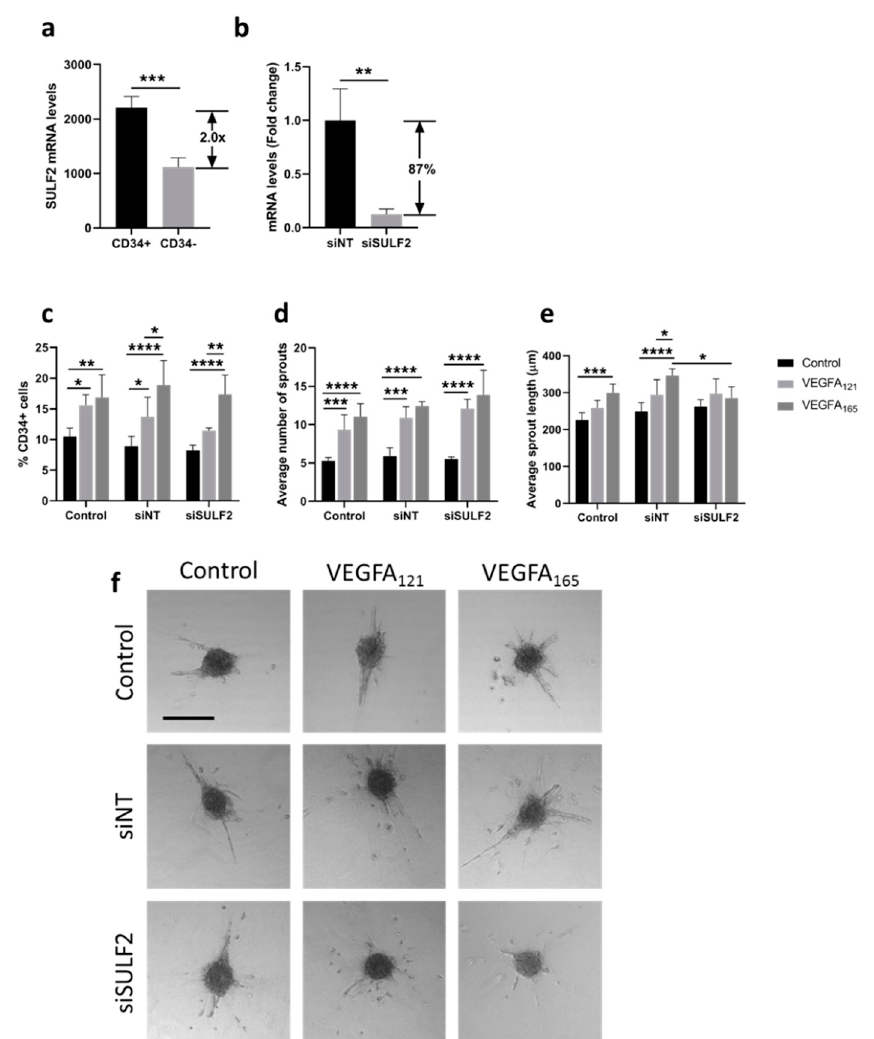
Figure 1. Effect of SULF2 knockdown on VEGFA121- and VEGFA165-induced tip cell formation and sprouting. ( a ) Microarray analysis showed enrichment of SULF2 mRNA in CD34 + cells as compared to CD34 - cells. HUVECs were treated with siNT, si SULF2 or left untreated (Control) and were subsequently cultured in the presence or absence of VEGFA 165 or VEGF 121 . ( b ) Treatment of cells with siSULF2 resulted in a significant reduction in mRNA levels of 87% as compared to treatment with siNT. ( c ) Flow cytometric analysis of CD34 + cells (% of total number of cells). Average number ( d ) and length in µm ( e ) of sprouts per HUVEC spheroid. ( f ) Representative images of sprout formation from HUVEC spheroids. Results are presented as the mean ± standard deviation of three HUVEC donors. Unpaired T-tests ( a , b ), two-way ANOVA ( c ) or two-way mixed ANOVA ( d , e ) were used to calculate statistical differences (* p < 0.05, ** p < 0.01, *** p < 0.001, **** p < 0.0001). Scale bar = 250 µm.